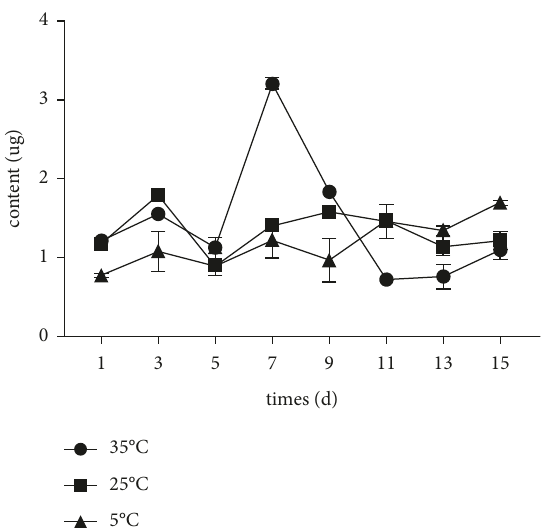
Figure 5: The content change curve at different temperatures of GA.